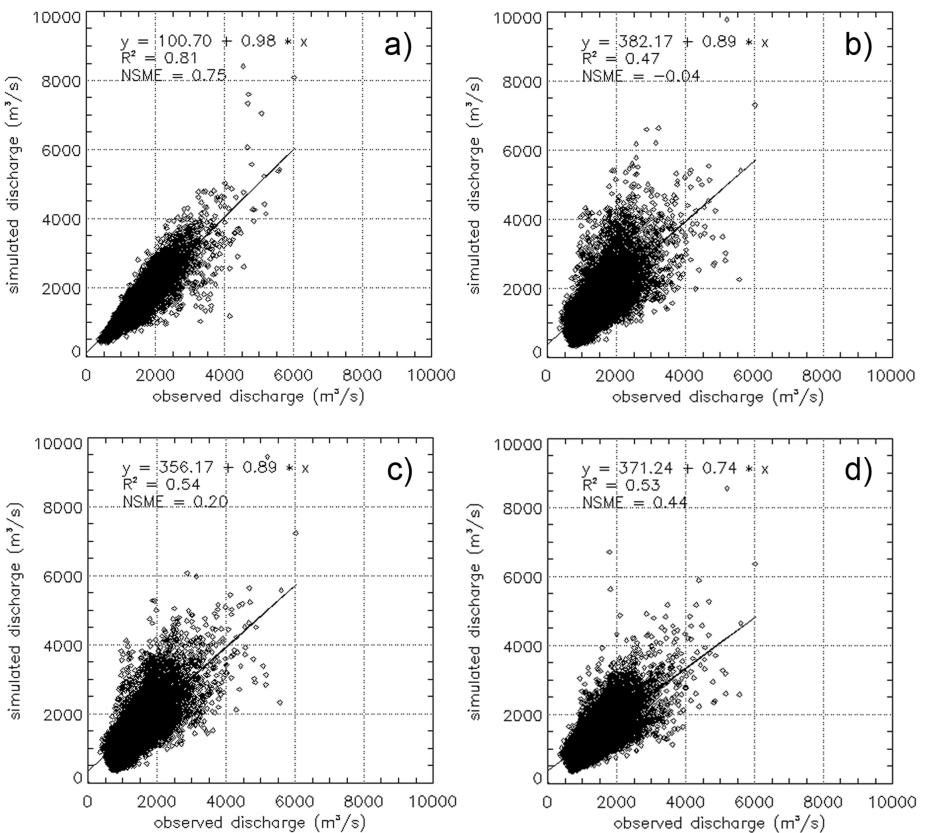
Fig. 6. Simulated versus observed daily discharge according to hydrological simulations driven by (a) meteorological observations, (b) bilin- early interpolated MM5 simulations (bil), (c) downscaled MM5 simulations (vari) and (d) downscaled and bias corrected MM5 simulations (vari&bias) 1972–2000. The MM5 simulations are driven with ERA40 reanalysis data, the discharge simulations for the downscaling ap- proaches vari and vari&bias have been conducted in two separate model runs (cross-validation) to avoid “in-sample” evaluation.